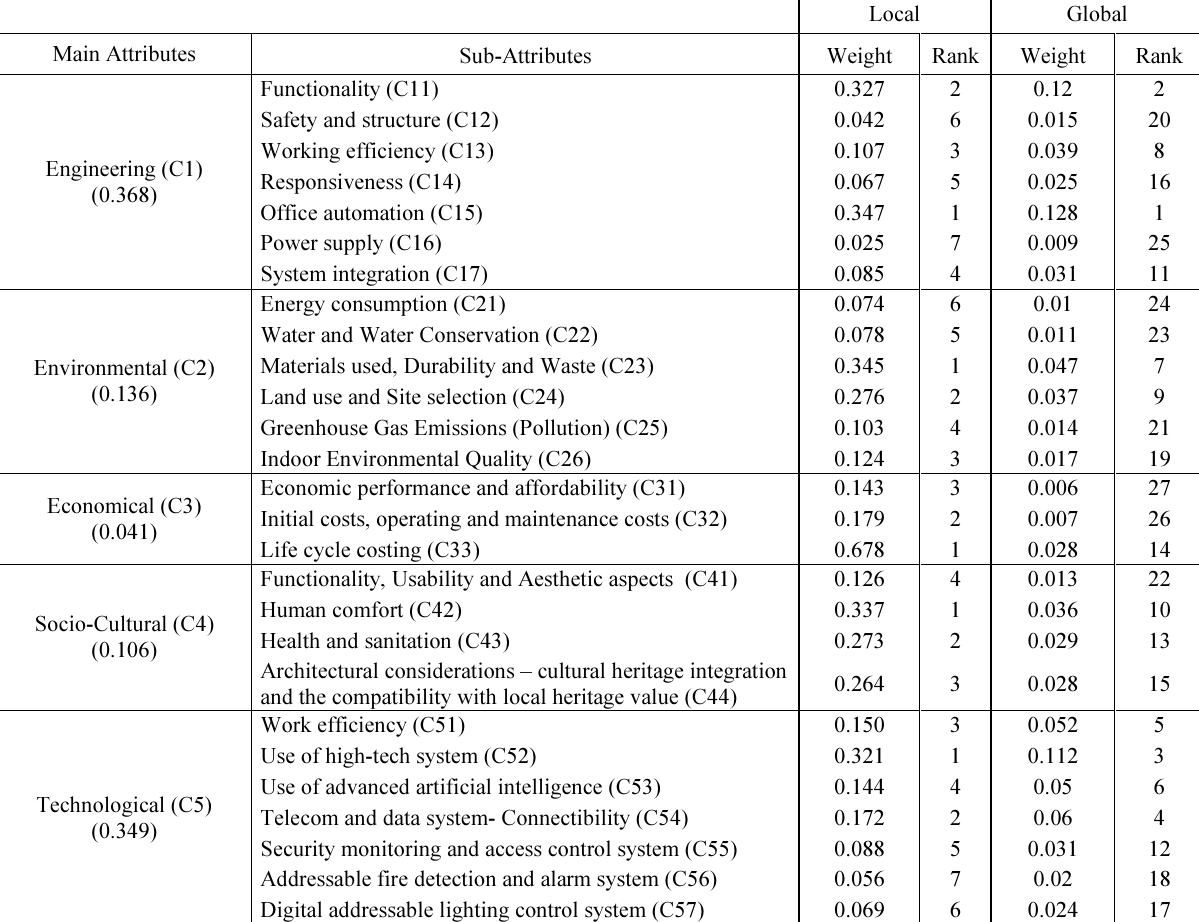
Fig. 4. Utility curves of various decision makers Table 2. The local and global weights & ranks of attributes for intelligent building